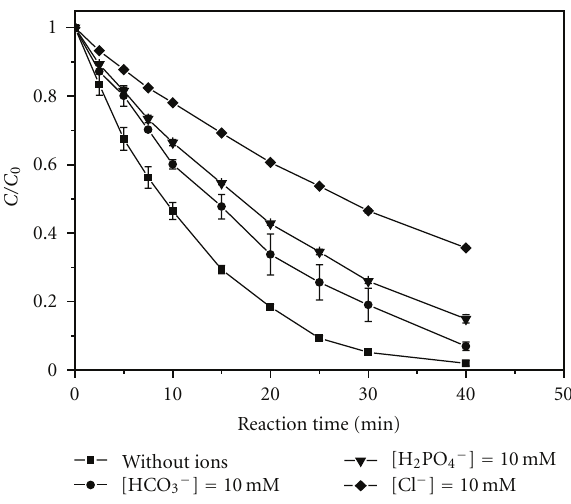
Figure 7: UV/Vis spectral changes of RhB with UV/K 2 S 2 O 8 treatment system. Conditions: [RhB] = 0.02 mmol/L, [K 2 S 2 O 8 ] = 0.4mmol/L, no pH